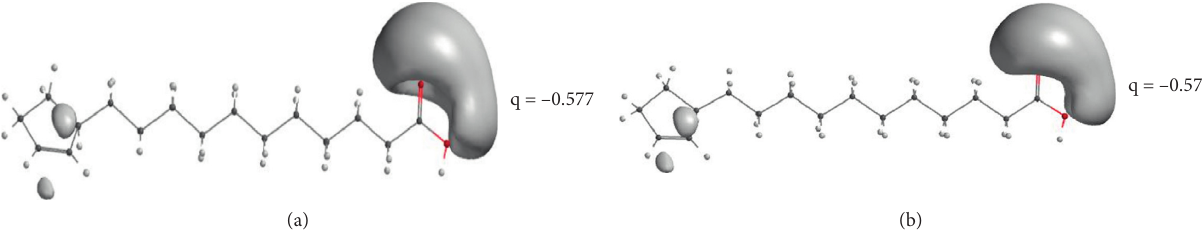
Figure 5: Electrostatic potential map of (a) chaulmoogric acid and (b) hydnocarpic acid.